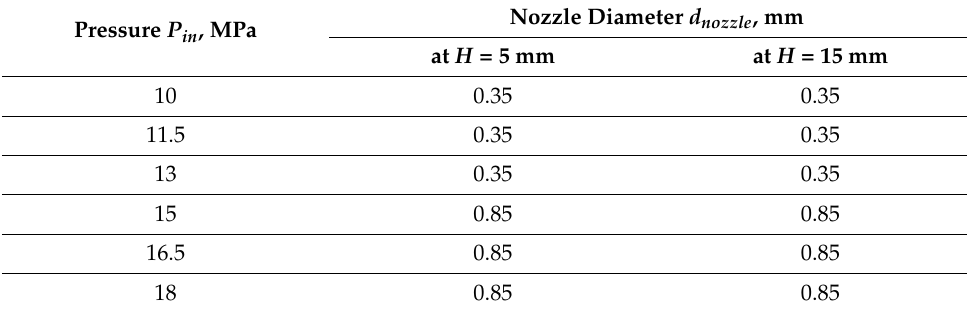
Table 4. Conditions of cavitation tests on coated aluminum samples.